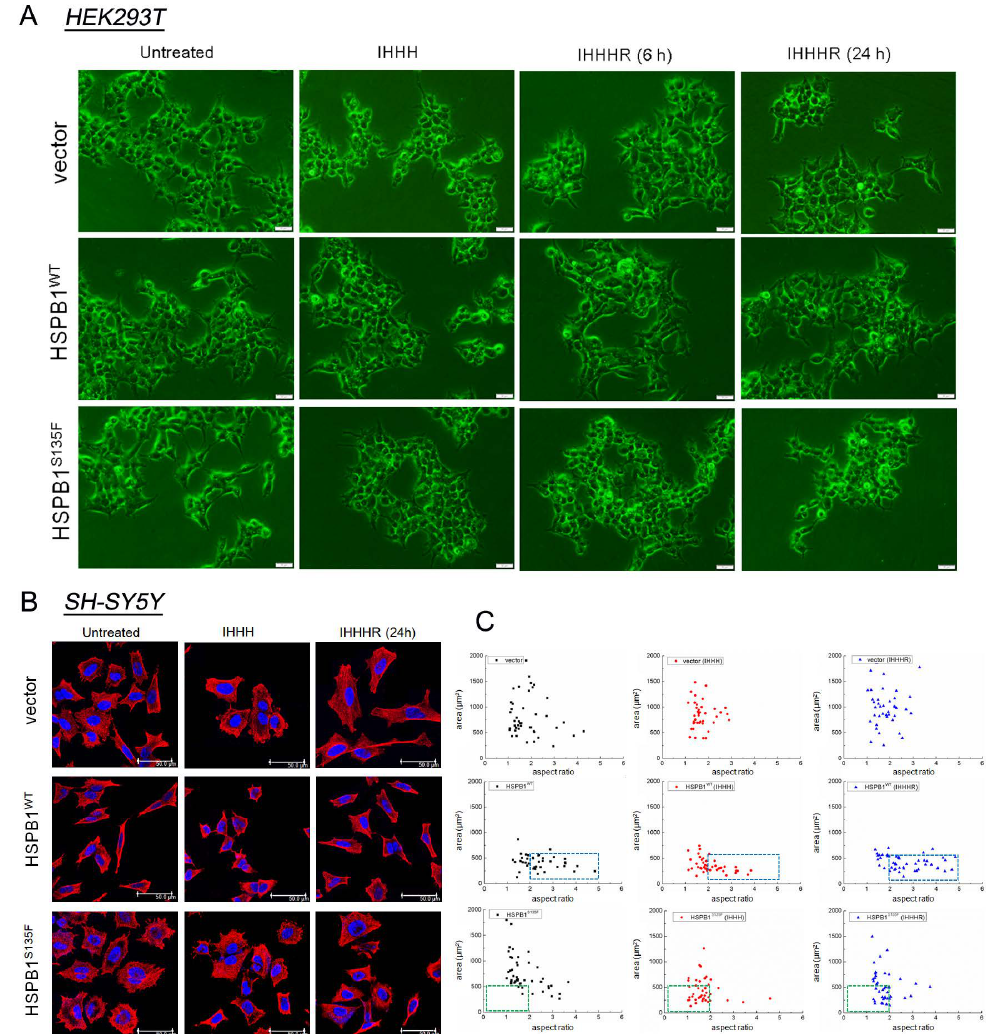
Figure 7. HSPB1 S135F decreases cell recovery from repeated heat shock. ( A ) Survival state of HEK293T cells treated with heat shock was observed by invert phase contrast microscope; scale bars: 50 µ m. ( B ) Cell morphology of SH-SY5Y was investigated by immunofluorescence staining of tubulin (red) and nucleus (blue); scale bars: 50 µm. ( C ) Cell area and aspect ratio of SH-SY5Y cells were measured and calculated by ImageJ; n > 40 per group. The blue boxes show complete recovery of HSPB1 WT -expressing cells from repeated heat shock, while the green boxes indicate that most of HSPB1 S135F -expressing cells cannot recovery from the repeated heat shock.